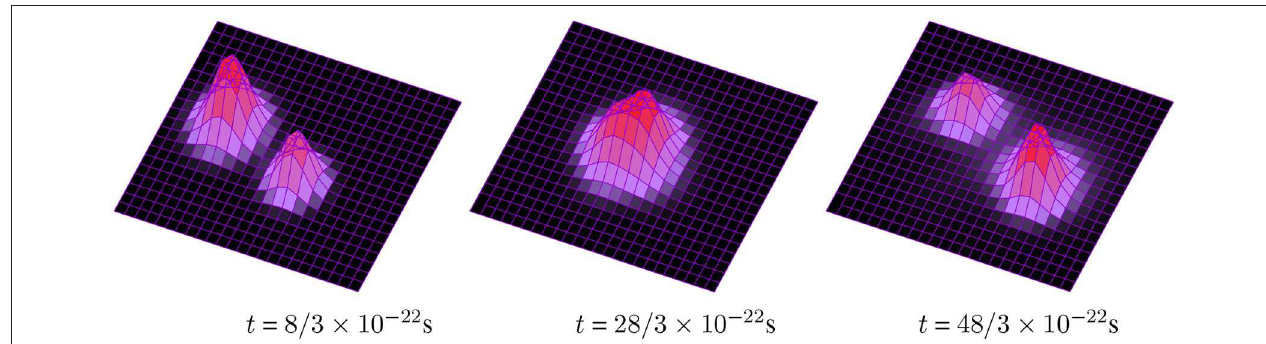
FIGURE 4 | Imperfect soliton including the spin degree of freedom, fermionic statistical property, the multi-dimensionality, and the effect due to the non-central collision. Time evolution of 8 He + 4 He for E K 7.50 MeV and b 3.0 fm are shown. The collision energy is around the upper-limit energy of fast charge equilibration = = [36]. That is, by increasing the energy, the transparent component becomes dominant. For better sights, time evolution of total density is depicted by projecting them on the reaction plane ( z 0). The density is plotted on the vertical axis taken from 0 to 0.6 fm − 1 , where the horizontal area is fixed to ( x , y ) = situation, 0.29 protons are transferred from 4 He to 8 He, and 0.26 neutrons are transferred from 8 He to 4 He, where we can find a weak effect of dual-way type charge equilibration [45] leading to the contamination of pure soliton. The self-bound property of 8 He and 4 He contributes to recovering the original shape if the transparencies of both mass and momentum is sufficiently high (kinetic energy loss is less than 5 MeV, see Figure 3 ).